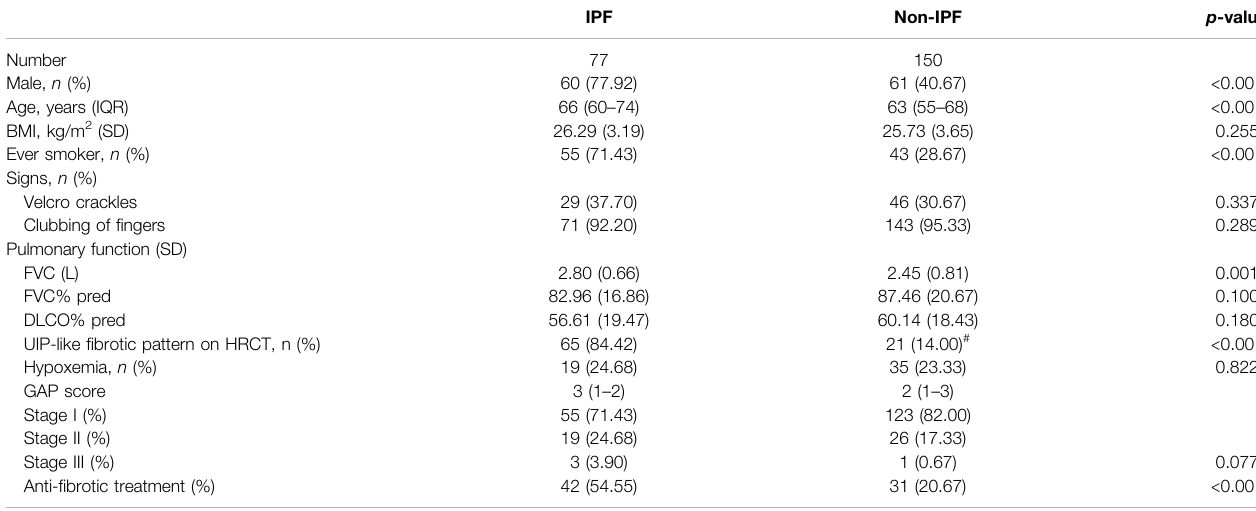
TABLE 2 | Demographics and clinical characteristics of patients within the PF